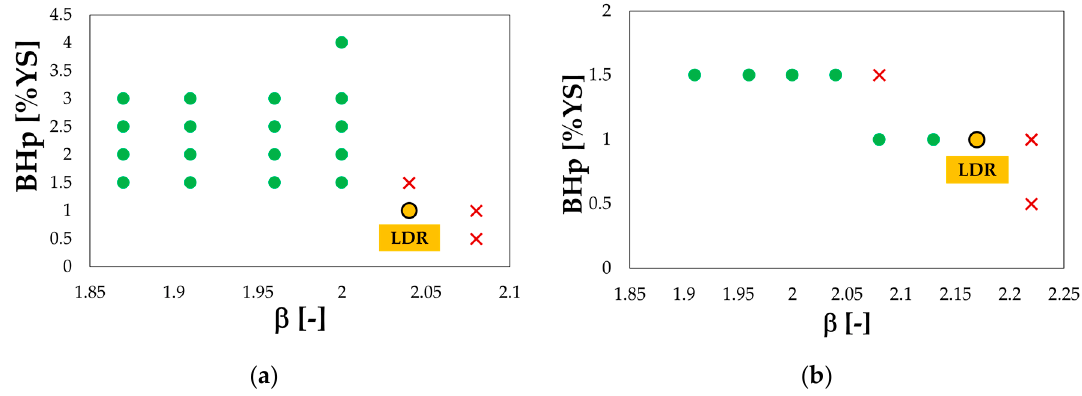
Figure 18. AA6082 experimental deep drawing tests: ( a ) T6 and ( b ) SHT condition.